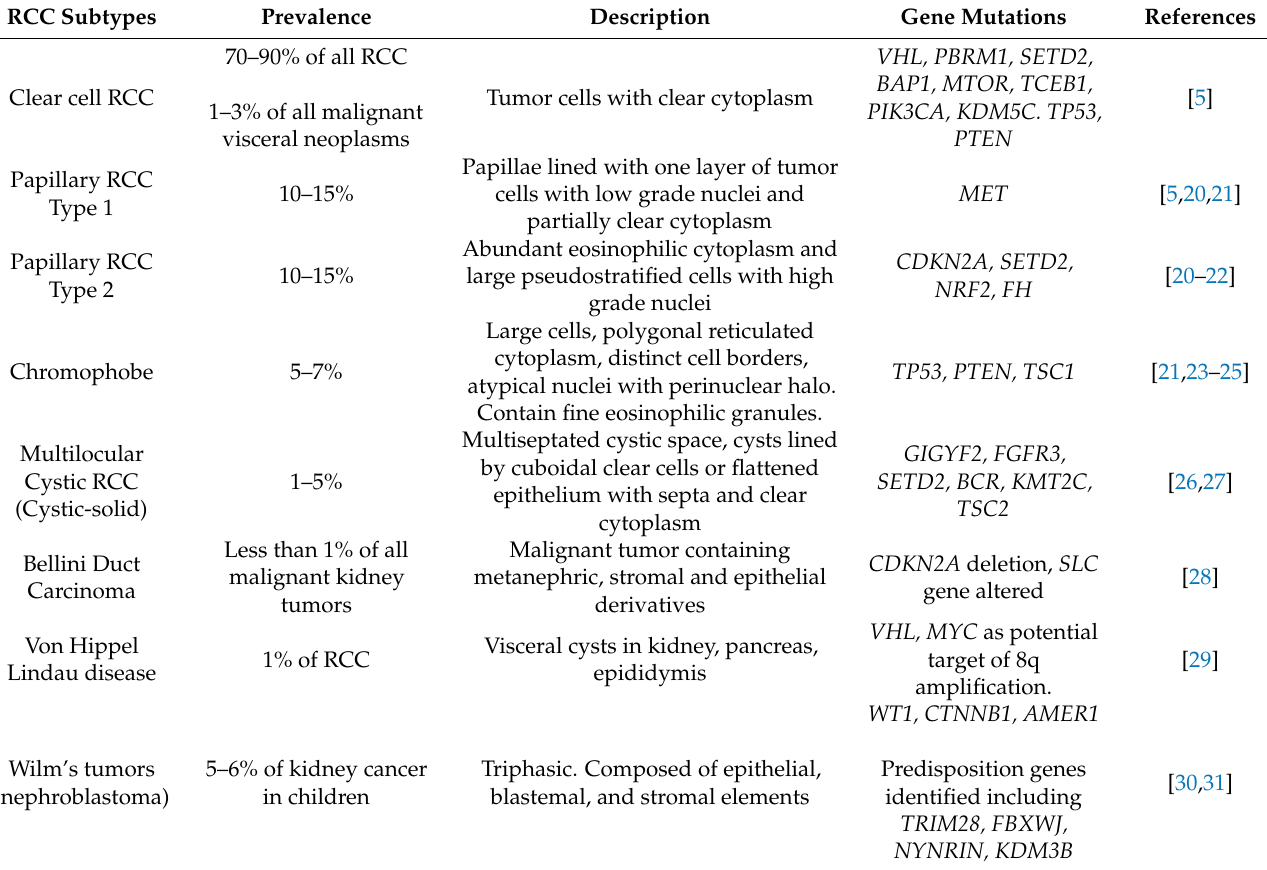
Table 1. Renal cell carcinoma (RCC) subtypes and